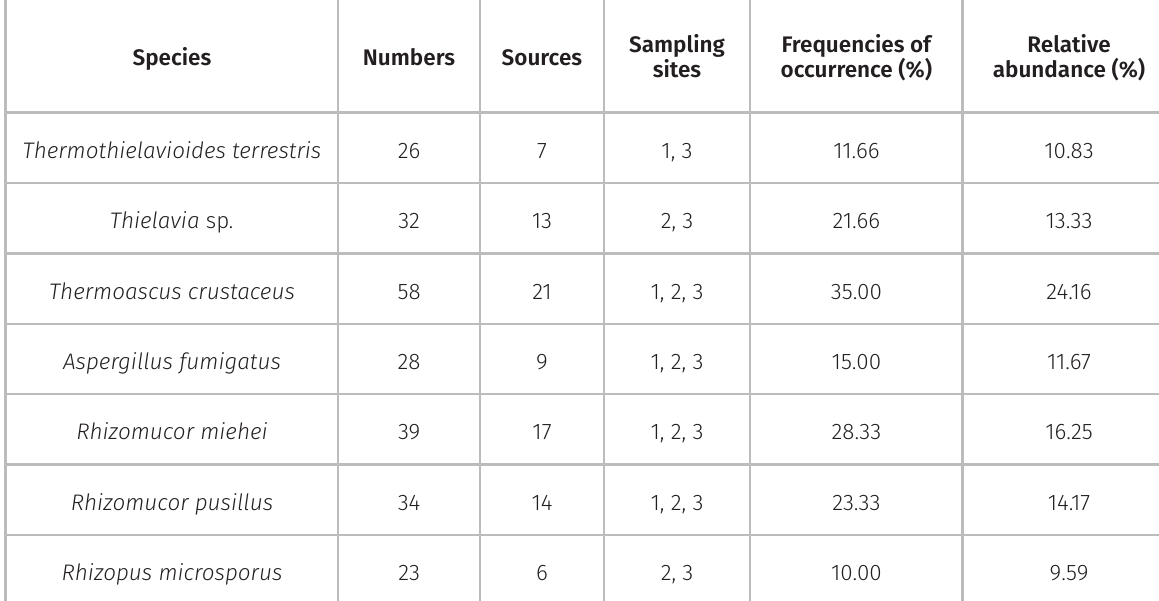
Table I. Thermophilic fungi from Atlantic Forest biome with their frequencies of occurrence and relative